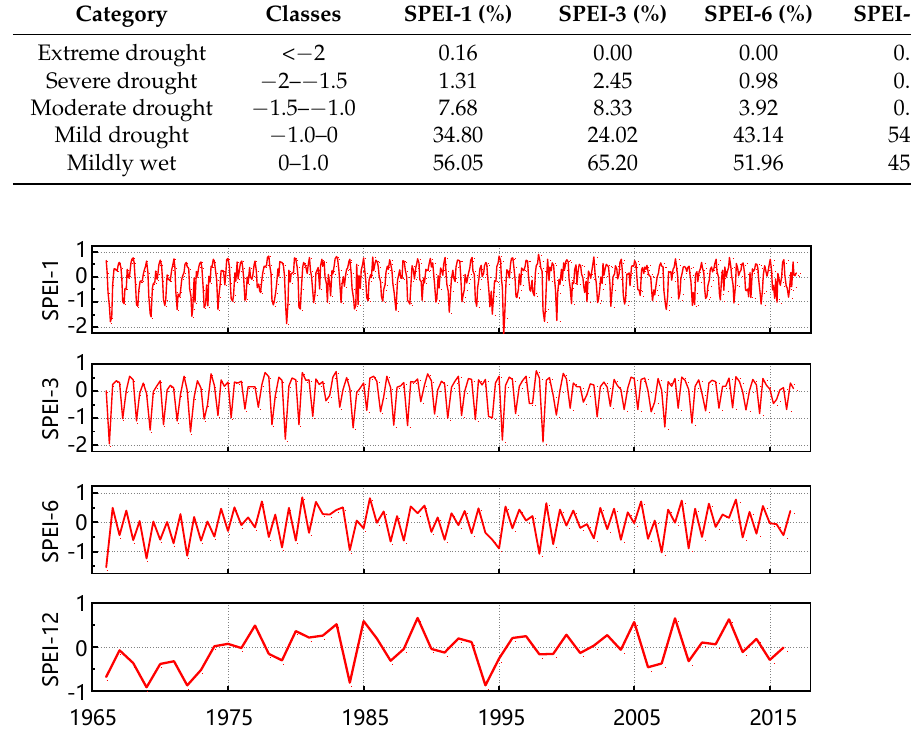
Figure 12. Temporal evolution of the SPEI at 1-, 3-, 6-, and 12-month timescales on the TP in 1966– 2016.